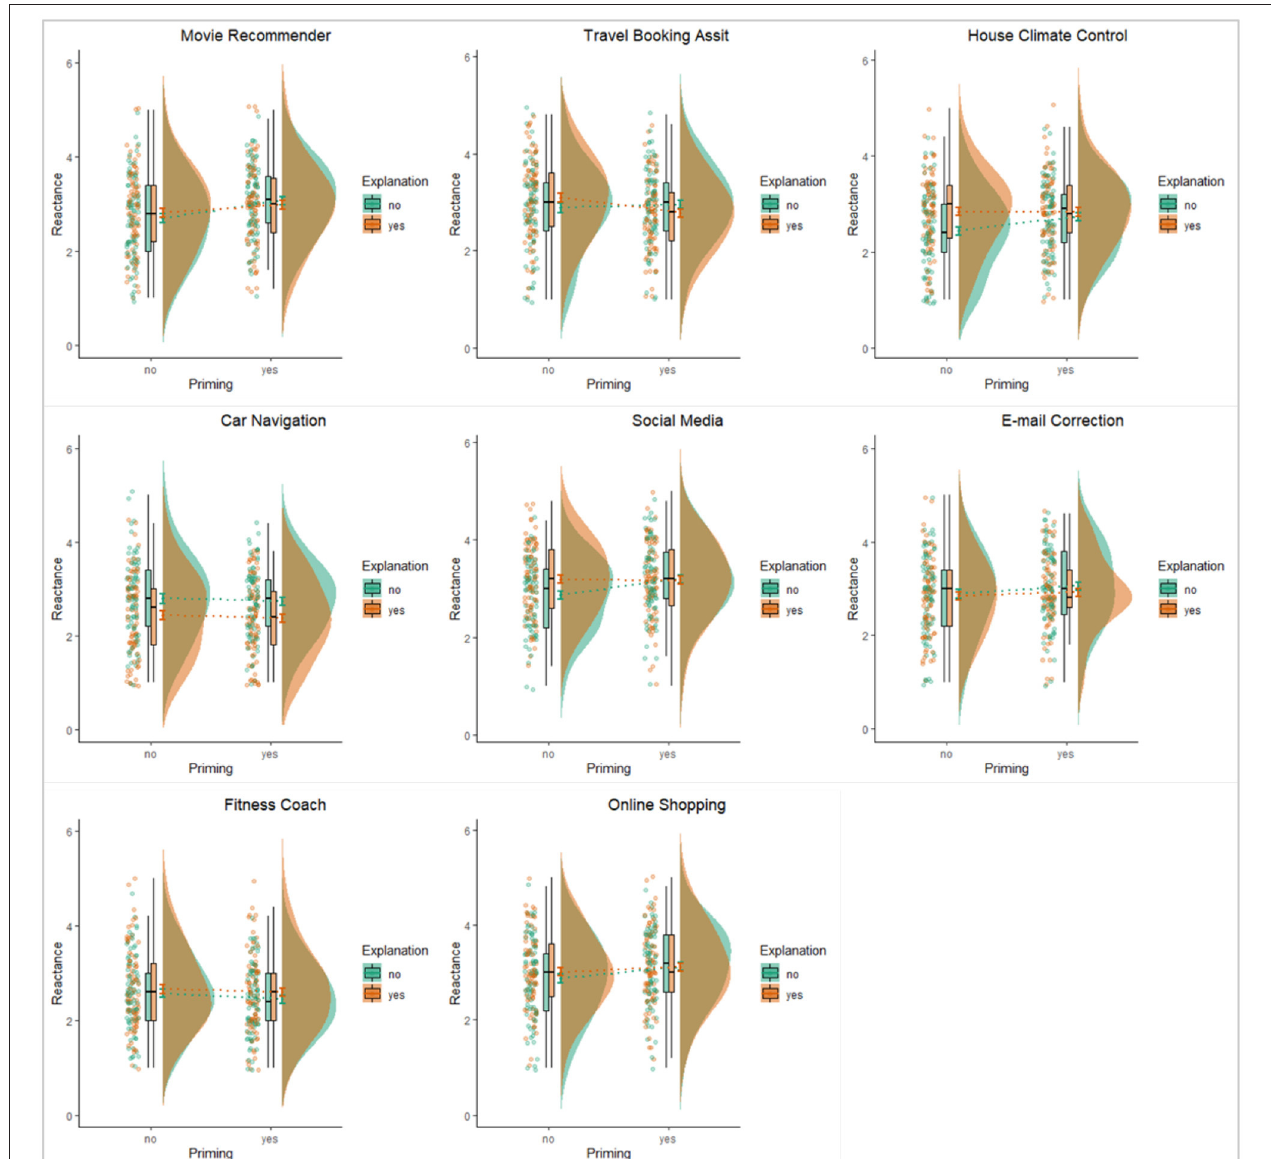
FIGURE 5 | Visualization of the effects of explanation and awareness on reactance for the eight specific application